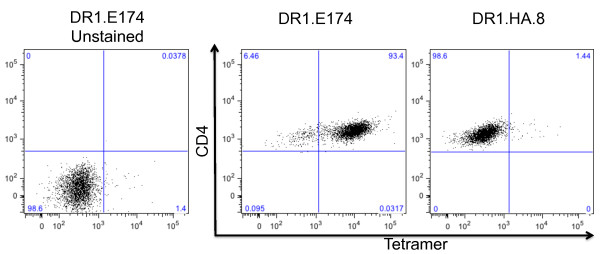
Functional analysis and specificity of the recombinant DR1-A12. Tetrameric DR1-A12 was tested for its ability to bind specifically to DR1-restricted, CII-specific T cells. A panel of T-cell hybridomas was cultured with the tetramers in saturating concentrations at 37°C for 3 hours. An anti-CD4 antibody was added in the last 30 minutes before the cells were washed and analyzed on the flow cytometer. The left panel demonstrates an unstained control. The middle panel shows hybridoma DR1.E174, which is representative of tests performed on nine individual CII-specific DR1-restricted hybridomas. The right panel (DR1.HA.8) is representative of four control T-cell hybridomas specific for an HA peptide in the context of DR1. Previous testing has shown that none of these hybridomas is bound by the irrelevant tetramer DR1-HA, which contains the immunodominant determinant of hemagglutinin [8]). These data confirm that that our A12/DR1-tetramer recognizes only the collagen-specific, DR1-restricted T cells in our panel.